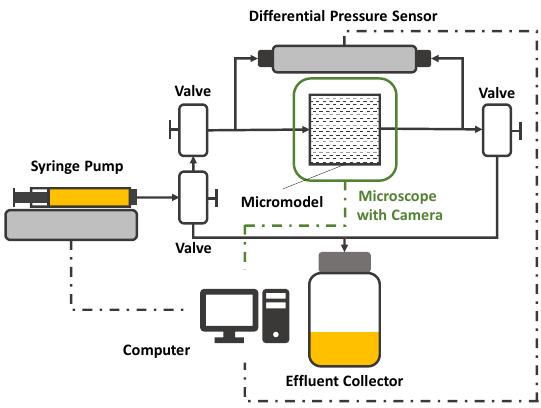
Figure 12. Microfluidic setup for quantitative and qualitative rheological measurements (modified after [69]).